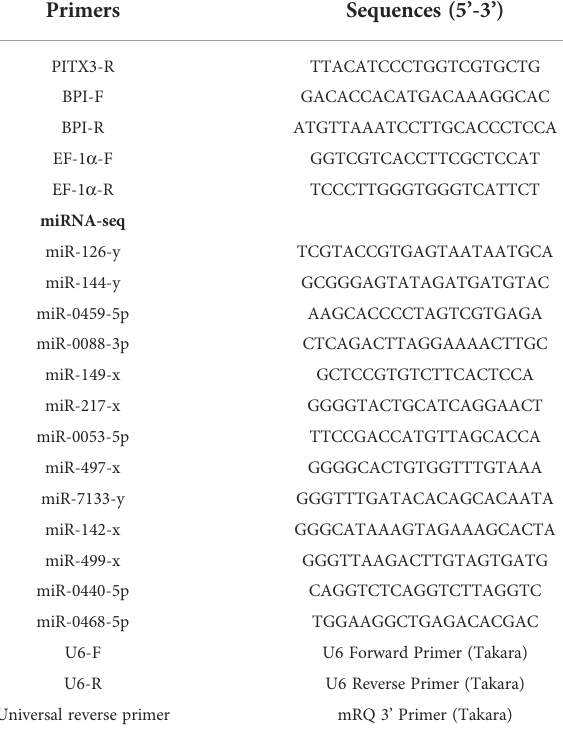
TABLE 3 The primer sequences used for qPCR